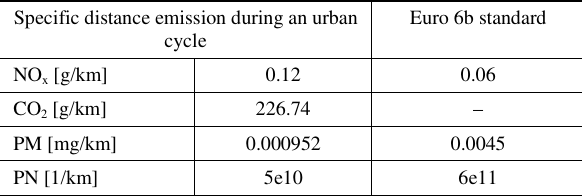
Table 3. Specific distance emissions results during an urban cycle